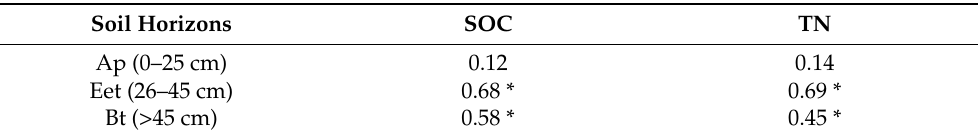
Table 5. Correlation coefficient between cumulative soil respiration and content of soil organic carbon (SOC) and total nitrogen (TN) in Ap, Eet, and Bt soil horizons.